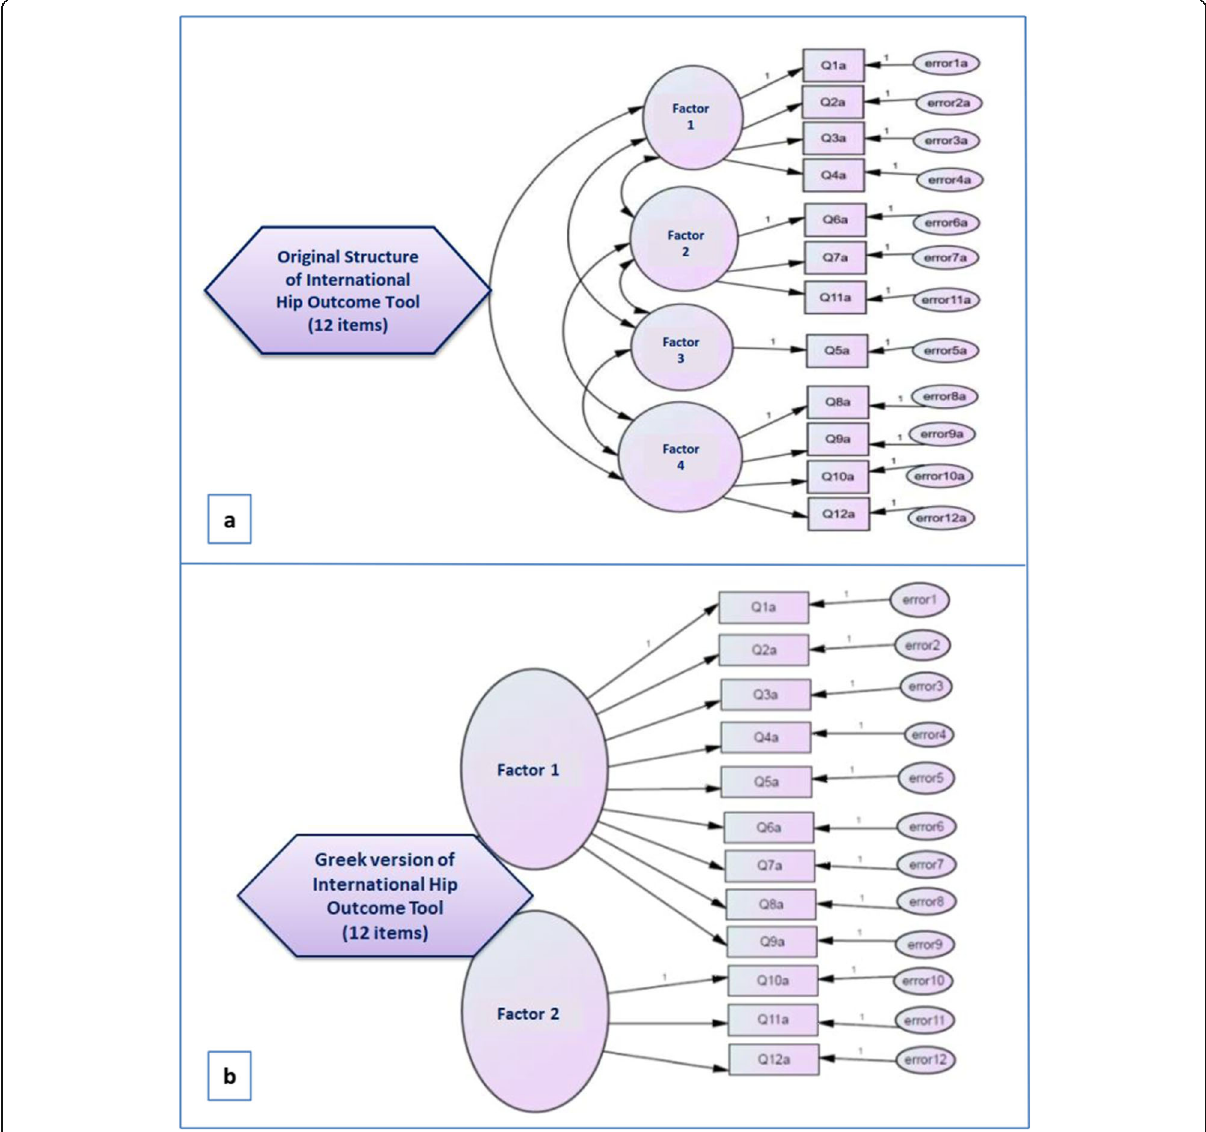
Fig. 2 a The four-factor model of the International Hip Outcome Tool – Greek version based on the original structure gave unacceptable global fit indices; b The two-factor model gave acceptable global fit indices: X 2 = 103.3, chi-square-degrees of freedom (d. f.) ratio = 1.95, RMSEA = 0.073, CFI = 0.927, NFI = 0.893, GFI = 0.865, AGFI =